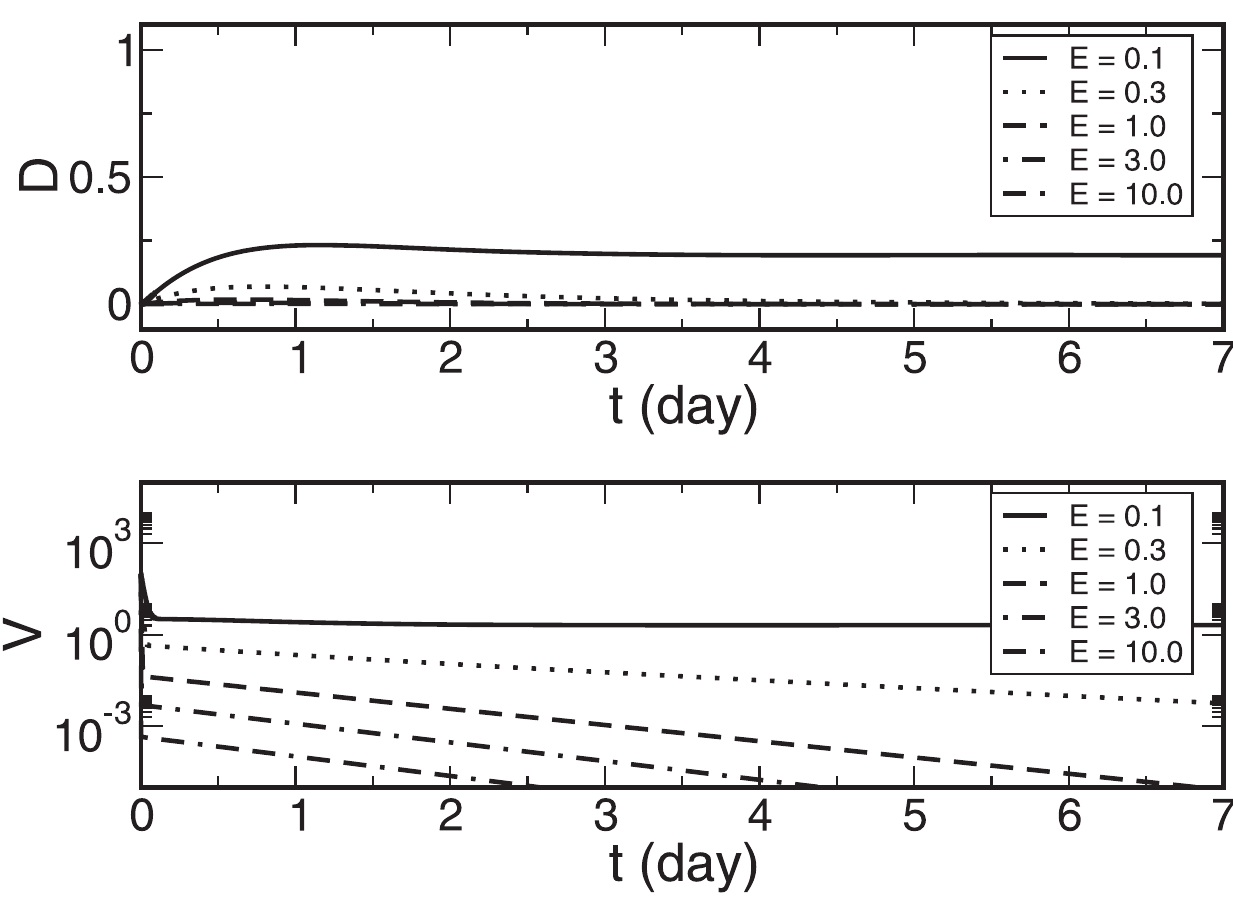
Figure 4. Trajectories of the concentration of dead cells D ð Þ and the viral load V ð Þ with different effects of immune response E ð Þ . In each trajectory, H 0 ð Þ ~ 1 , I 0 ð Þ ~ 0 , V 0 ð Þ ~ 100 , and E is constant. When t ? ? , viruses cannot be cleared at small values of E , such as 0.1. The decay rates of both D and V increase with E .